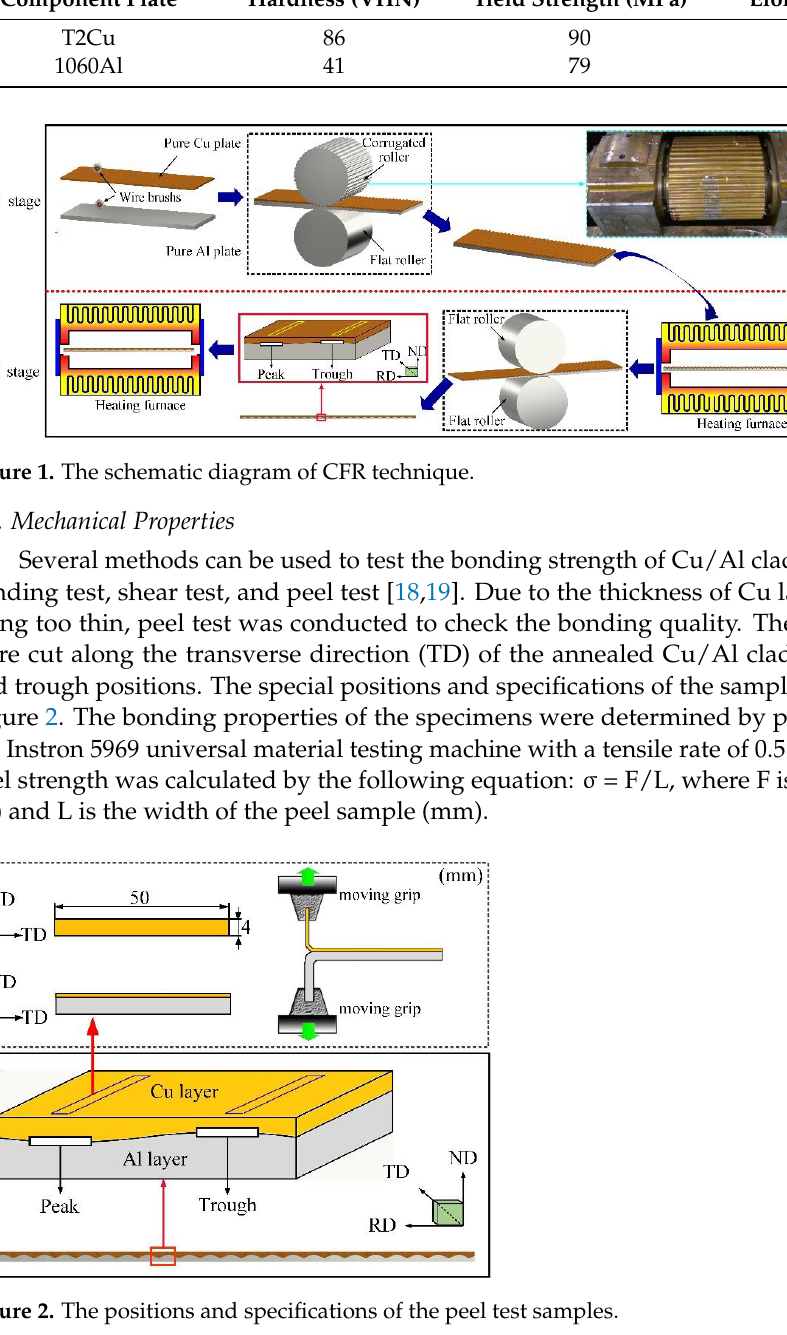
Table 2. The mechanical properties of raw T2 Cu and 1060 Al.